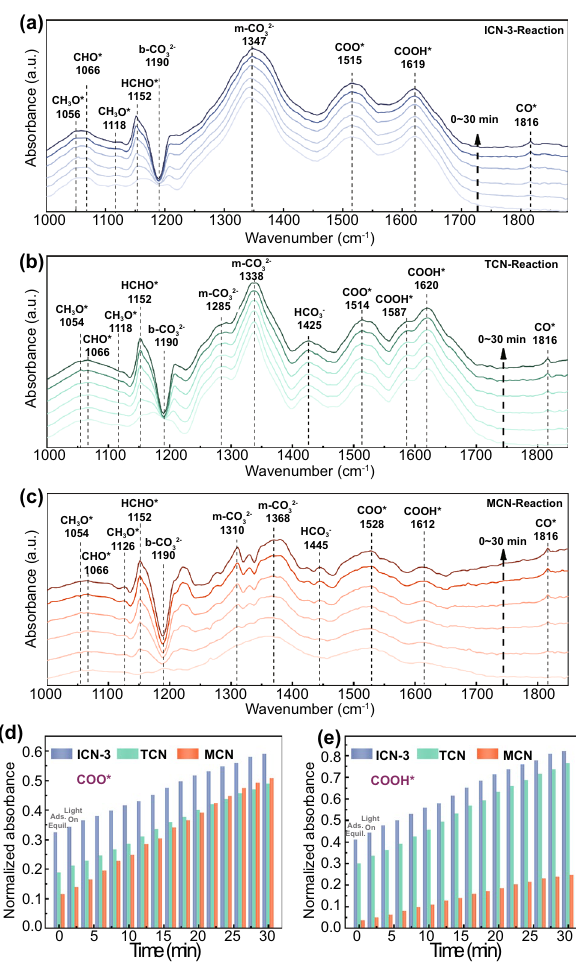
Fig. 6 In situ DRIFTS analysis of photocatalytic CRR over a ICN- 3, b TCN and c MCN. Normalized absorbance of d COO* and e COOH* on ICN-3, TCN and